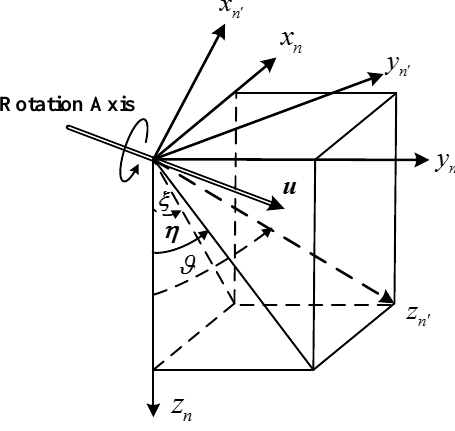
Figure 6. The geometric relation between the two navigation coordinate frames.